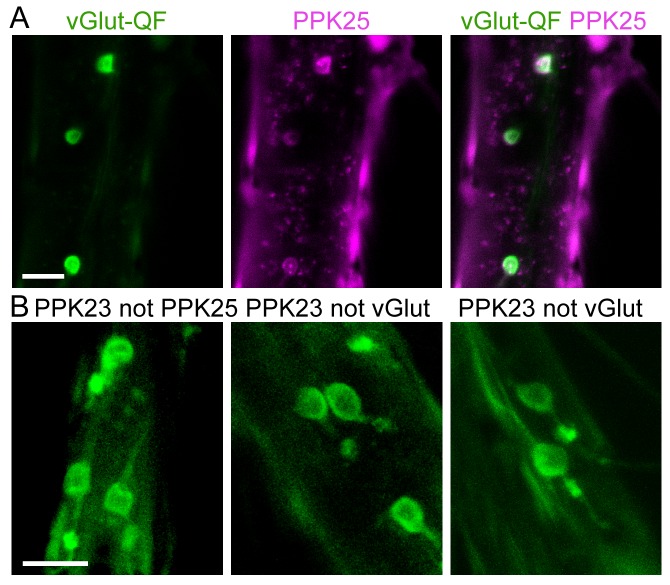
Approach to selectively target F or M cells.(A) vGlut-QF (green) is expressed in PPK25 cells (magenta), similar to vGlut-LexA in Figure 1D. Flies were vGlut-QF2, QUAS-Gal80, ppk25-Gal4, UAS-CD8::tdTomato. (B) (left), Ablating F cells (ppk25-Gal4) using diphtheria toxin leaves M cells intact, with one GFP-positive cell/bristle rather than two. This strategy was used to label M cells in Figure 1G. (middle), Suppressing Gal4-dependent expression in F cells (ppk23-Gal4, UAS-CD8::tdTomato, vGlut-LexA, lexAop-Gal80) leaves expression intact in M cells. This strategy was used to activate M cells in Figure 1H. (right), Suppressing LexA-dependent expression in F cells (ppk23-LexA, lexAop-CD2::GFP, vGlut-QF2, QUAS-Gal80) leaves expression intact in M cells. This strategy was used to activate M cells in Figures 2B, 4B, and 5E. Different approaches were used to accommodate chromosome locations of transgenes. Scale bars, 10 μm.